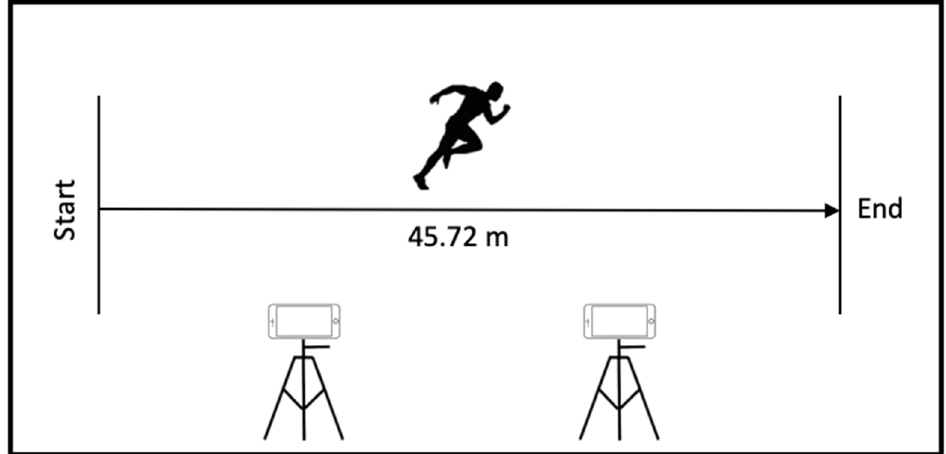
Figure 2. Experimental set-up of the sprint test over half a field hockey pitch (45.72 m) with two smartphone cameras recording the performances (Camera 1: 0 to 22.86 m, Camera 2: 22.86 m to 45.72 m).